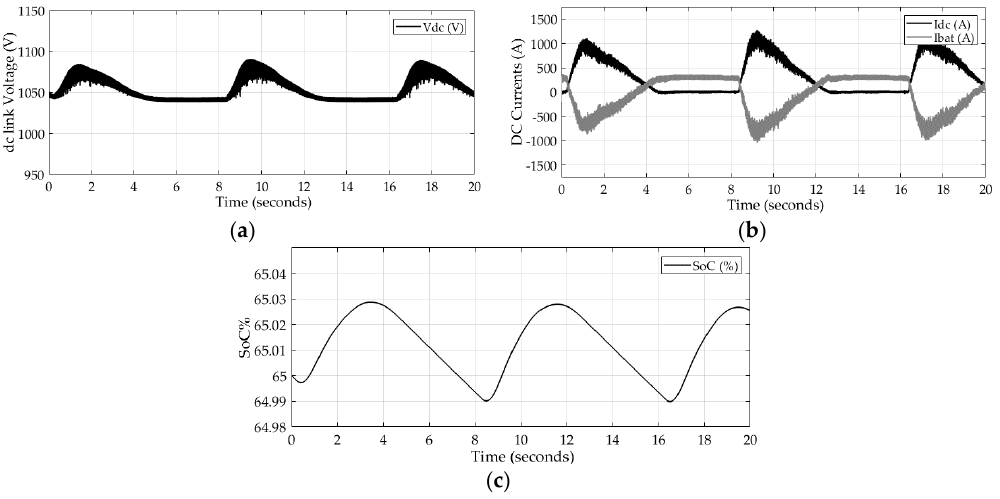
Figure 7. The performance of energy storage and the dc-link: ( a ) dc link voltage v dc (V); ( b ) dc link current I dc (A) and battery current I bat (V); ( c ) state of charge of the battery SoC%.